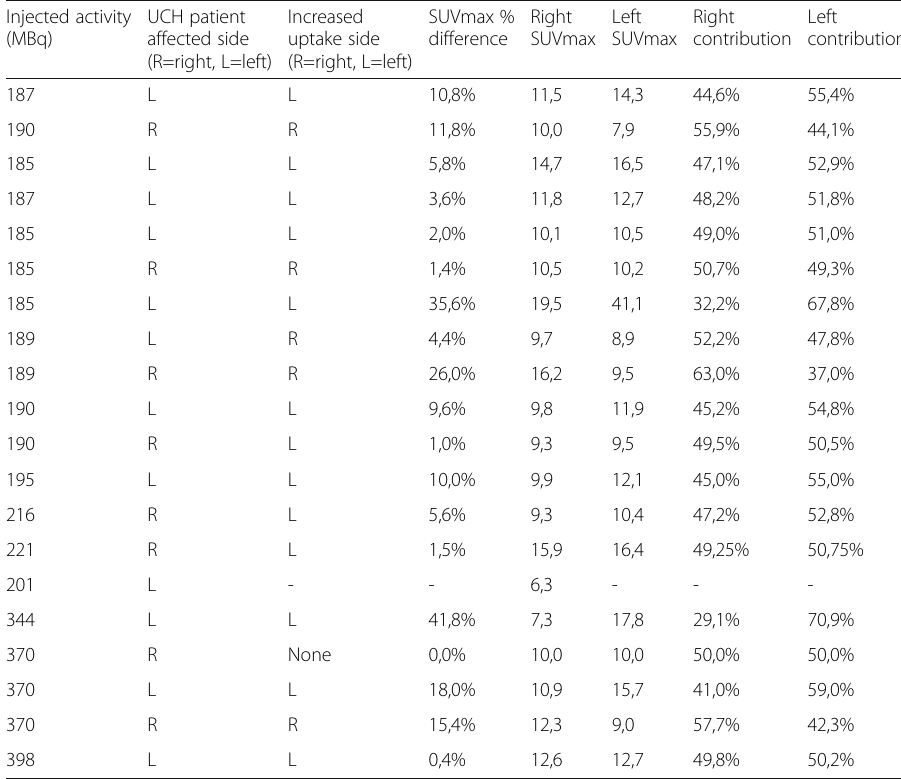
Table 1 18-F Fluoride PET/CT UCH patient results Injected activity